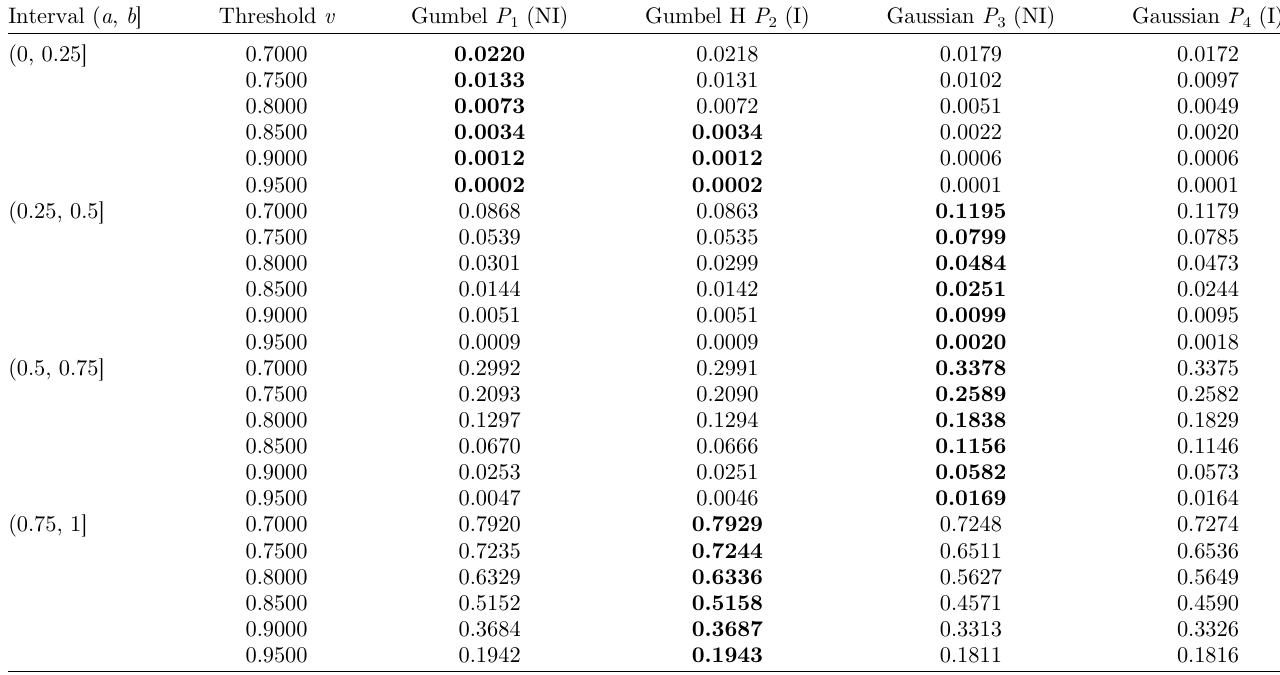
Table 5. Case H f vs. D max (see Tab. 3). From left to right: interval ( a , b ], v lower threshold of V , P i = Prob i ( V > v | U 2 ( a , b ]) following equation (8), i = 1, 2 and equation (7), i = 3, 4, Non Informative settings i = 1, 3 and Informative settings i = 2, 4. In bold, the highest probability per